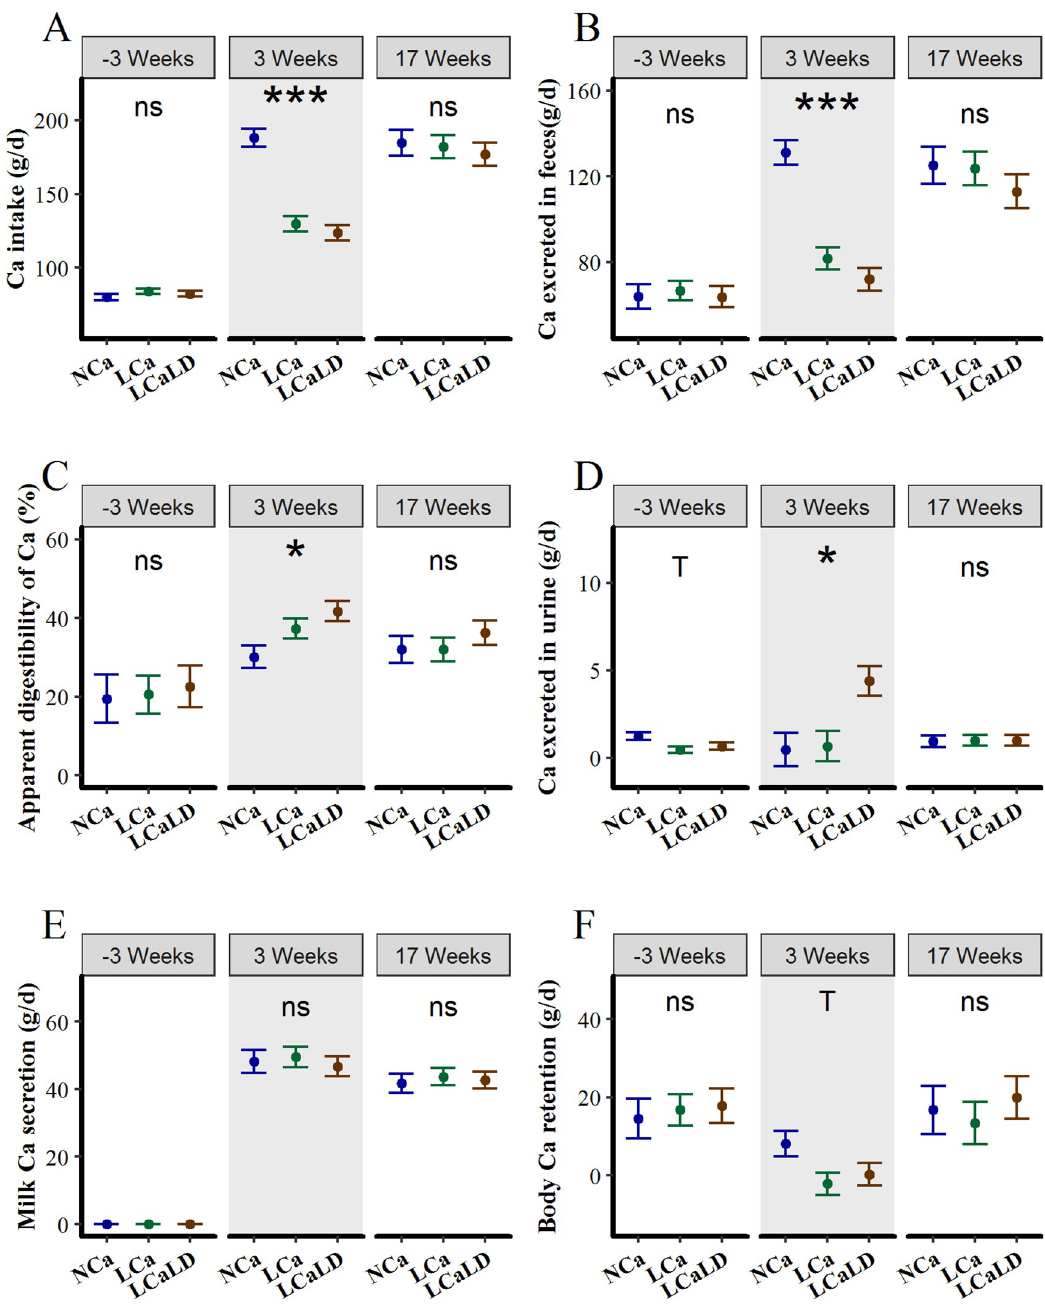
Fig 4. Effect of transient variation in dietary Ca content and the DCAD on A) daily Ca intake, B) fecal losses of Ca, C) apparent digestibility of Ca, D) urinary losses of Ca, E) Ca secretion in milk and F) Ca balance at 3 weeks before and after calving and at 17 weeks after calving. NCa = normal Ca (4 cows), LCa = low Ca (5 cows), LCaLD = low Ca and low DCAD (5 cows). Gray background specifies the period during which cows were fed differentiated diets according to the treatments. Data were analyzed according to a one-way ANOVA using PROC GLM in SAS [35] at each stage of lactation, considering only the fixed effect of treatment. Symbols represent P-values of the treatment effect: ns = not significant, i.e., P > 0.10; T = tendency, i.e., P < 0.10; � = significant, i.e., P < 0.05; �� = significant, i.e., P < 0.01; and ��� = significant, i.e., P < 0.001. Vertical bars represent standard errors of the mean.